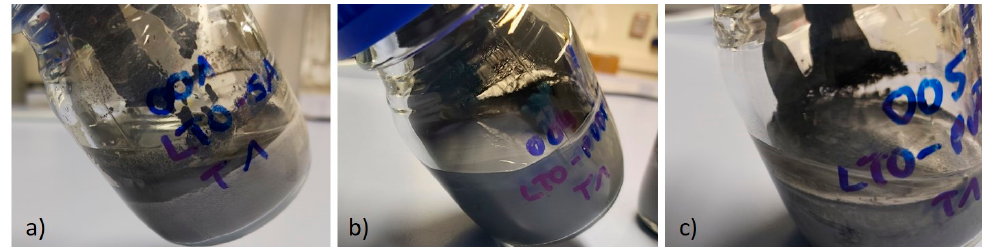
Figure 6. Di ff erence between the slurries 7 days after mixing with: ( a ) LTO-SA, ( b ) LTO-PVDF / CMC Figure 6. Difference between the slurries 7 days after mixing with: ( a ) LTO-SA, ( b ) LTO-PVDF/CMC and ( c ) LTO-PVDF / SA binder systems. and ( c ) LTO-PVDF/SA binder systems . Figure 6. Difference between the slurries 7 days after mixing with: ( a ) LTO-SA, ( b ) LTO-PVDF/CMC Figure 6. Difference between the slurries 7 days after mixing with: ( a ) LTO-SA, ( b ) LTO-PVDF/CMC and ( c ) LTO-PVDF/SA binder systems . and ( c ) LTO-PVDF/SA binder systems .